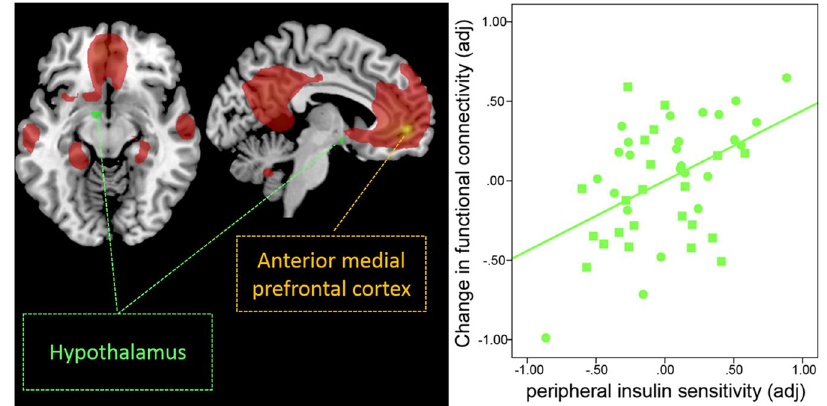
Figure 5. Intranasal insulin increases functional connectivity (FC) between the hypothalamus and the anterior medial prefrontal region of the default-mode network in peripherally insulin sensitive participants. Group-averaged DMN of lean and overweight/obese participants under baseline condition (rs fMRI1 ) for the anterior medial prefrontal cortex (PFC) seed region is displayed in red (p FWE < 0.05, whole-brain corrected). Bright green color-coded region reveals voxels within the hypothalamus showing a significant change in functional connectivity with the anterior medial PFC of the DMN, as identified by a significant interaction between condition (insulin versus placebo spray) and the peripheral insulin sensitivity index (p FWE < 0.05 small volume corrected). Partial correlation plot on the right shows a significant positive correlation between peripheral insulin sensitivity index and the change in functional connectivity between the anterior medial PFC and hypothalamus. With higher peripheral insulin sensitivity, we observed a stronger increase in functional connectivity adjusted for total intracranial volume, sex, age and visceral adipose tissue (r adj = 0.459, p = 0.002). Circles represent lean participants and squares represent overweight and obese participants. No such relationship was observed after placebo